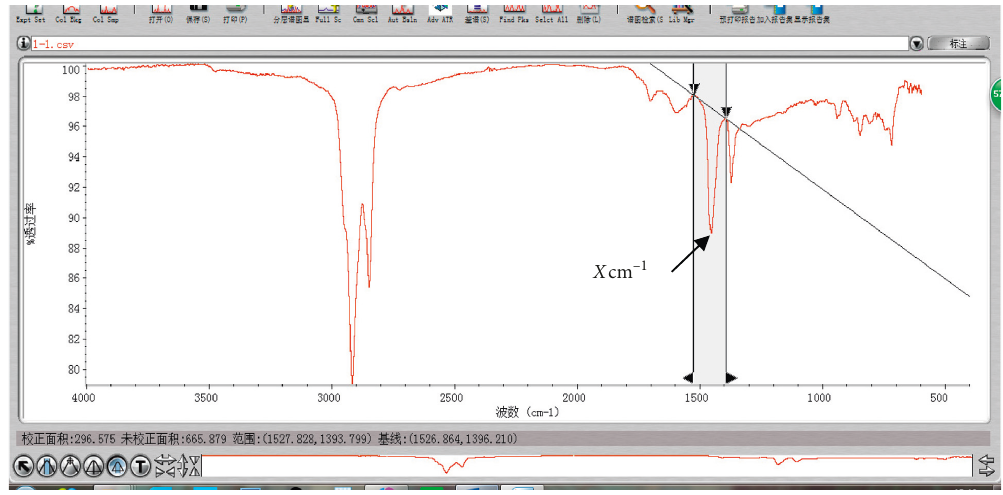
Figure 2: Schematic diagram of the functional group area at X cm − 1 .